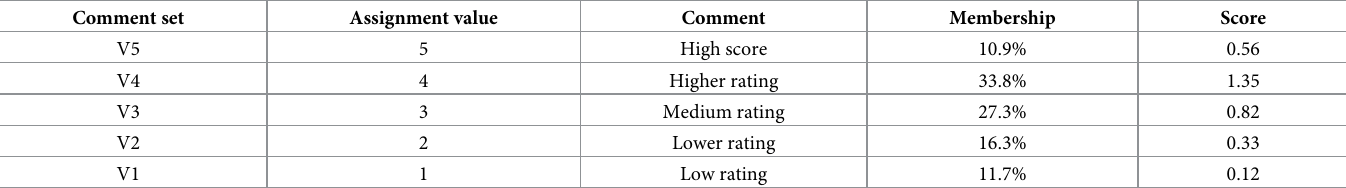
Table 6. Comparison of simulation results under actual conditions.